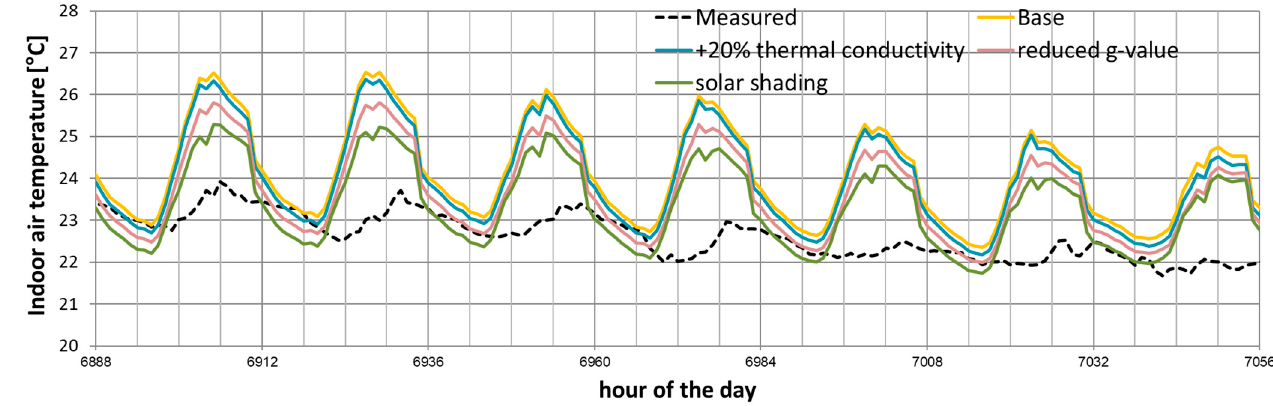
Figure 4. Sensitivity analysis—PoliTO-EnergyPlus (3rd week October 2017).